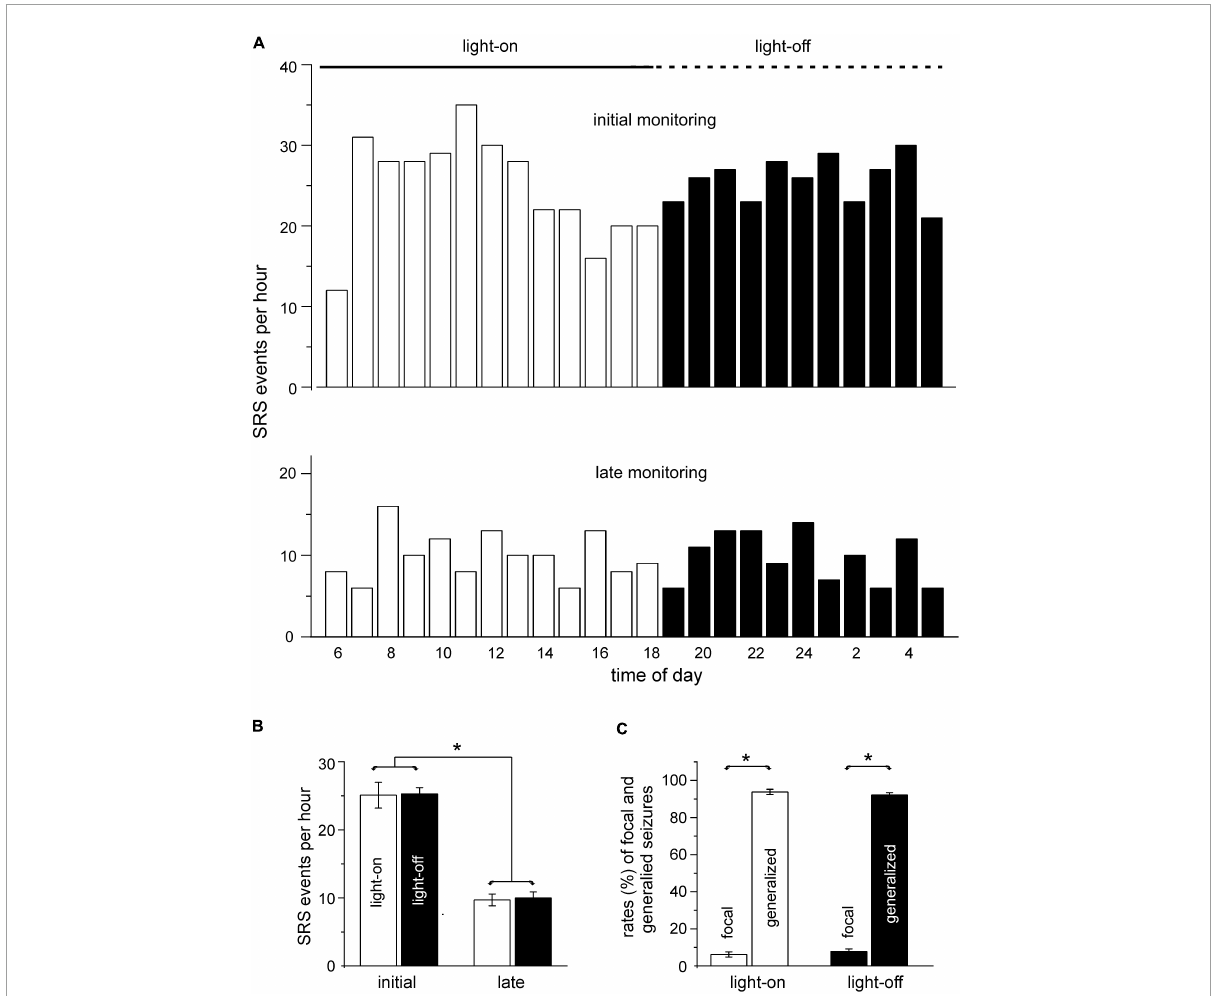
FIGURE4 Spontaneous recurrent seizures (SRS) observed during the light-on and light-off periods. Data were collected from mice of the five implantation groups. SRS were detected within 10 days (initial monitoring period; 695 events from 35 mice) or 6–12 weeks (later monitoring period; 240 events from 14 mice) after termination of kindling stimulation. (A) Summed SRS incidence per hour plotted against times (24 h) of day. The light on or light off periods indicated by a solid or dotted line above the graph. (B) Mean seizure incidences estimated for the light on and light off periods. Seizure incidences between the light on and light off periods were not significantly different ( p = 0.93 or 0.788) in both monitoring periods, but overall seizure incidences were significantly lower in the late than in the initial monitoring period ( p < 0.001, Student’s t -test). (C) Overall rates of focal and generalized seizures estimated for the initial and late monitoring periods. Note that the rates of generalized or focal seizures were similar between the light on and light off periods and that there were greater rates for generalized seizures relative to focal seizures in both the initial and later monitoring periods (* p ≤ 0.05, one-way